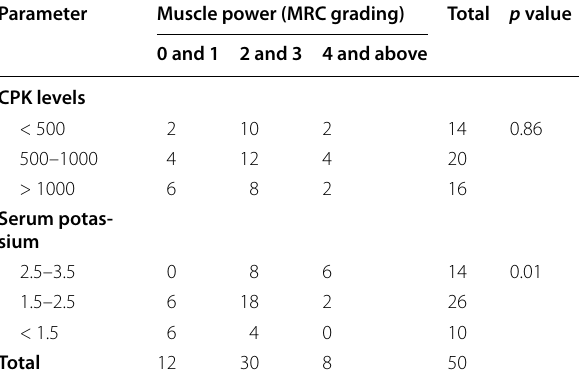
Table 2 Co-relation between serum potassium and CPK